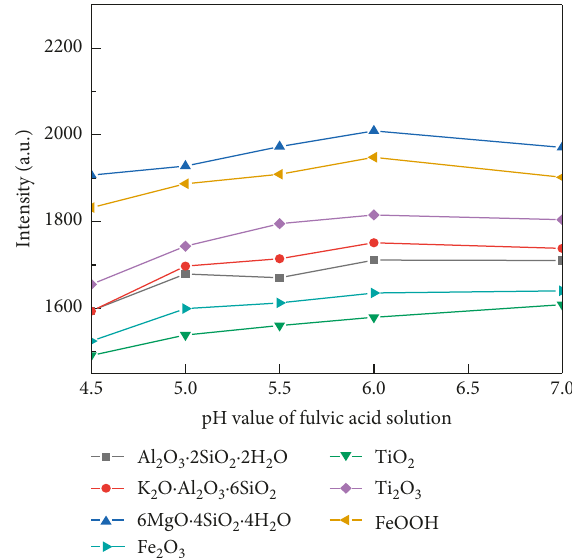
Figure 15: Relationship curve between diffraction peak value of main substances (except SiO 2 ) and pH value of FA